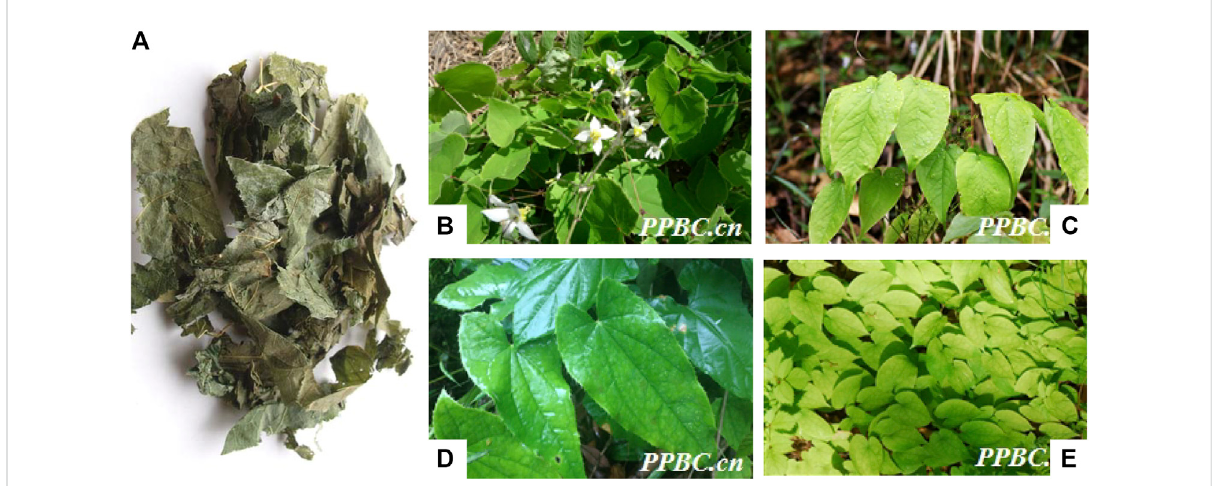
FIGURE 1 EpimediiHerba (A) (https://www.daquan.com/)isthedriedleavesoriginatedfromseveralplantsofthegenusEpimedium,including Epimedium brevicornu Maxim (B) , Epimedium sagittatum (Sieb. EtZucc.) Maxim (C) , Epimedium pubescens Maxim (D) and Epimedium koreanum Nakaias (E) (Cited from plant photo bank of China at